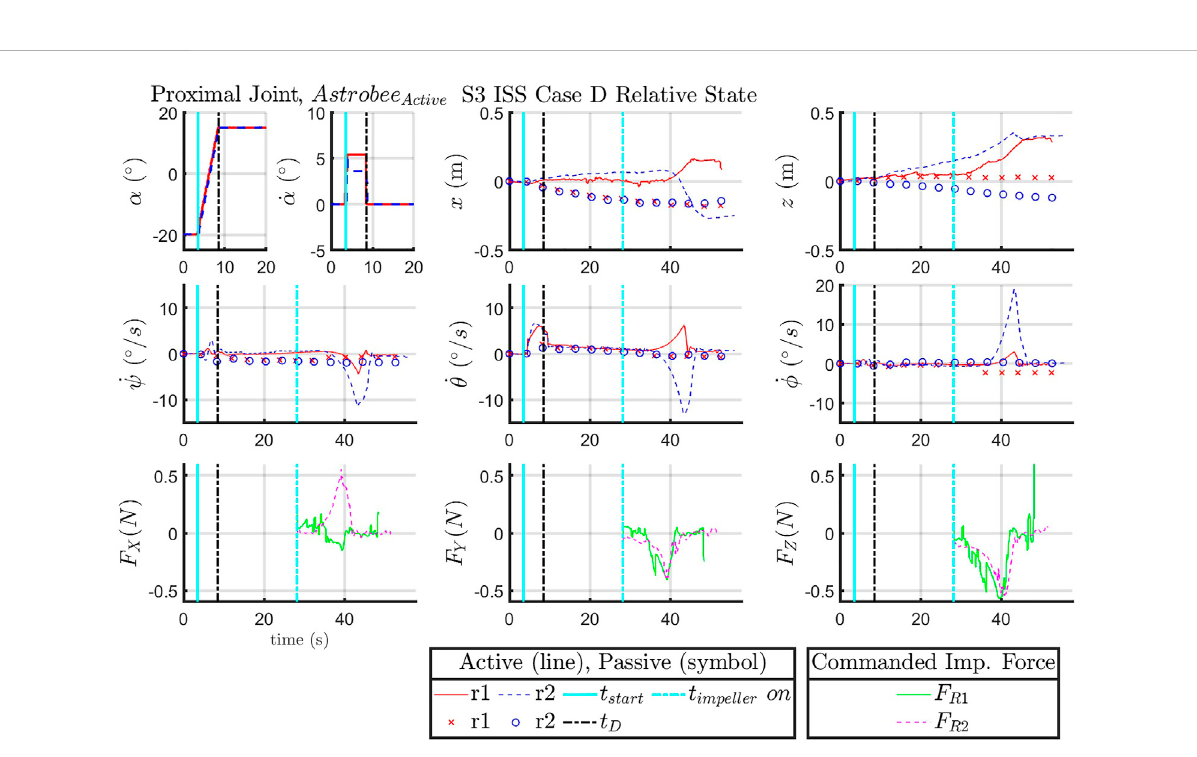
FIGURE A4 ISS: State data collected case